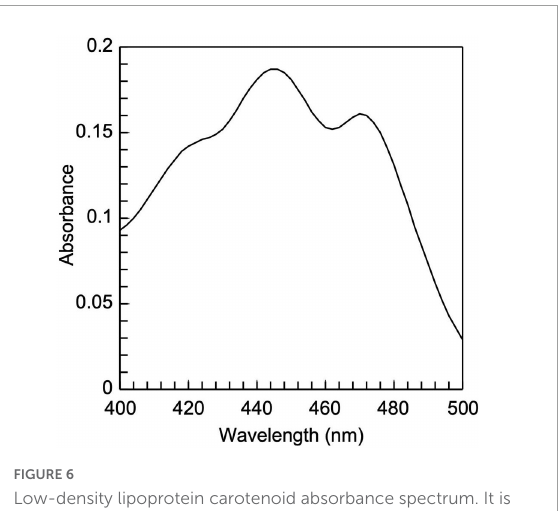
FIGURE6 Low-density lipoprotein carotenoid absorbance spectrum. It is composed of two peaks, 448 and 470 nm, which are typical of